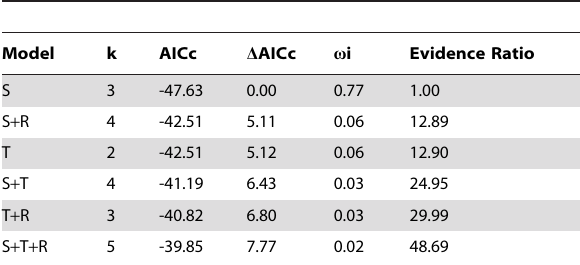
Table 2. A list of species sampled for the presence of Bd, organized by families (bold); salamanders followed by frogs.